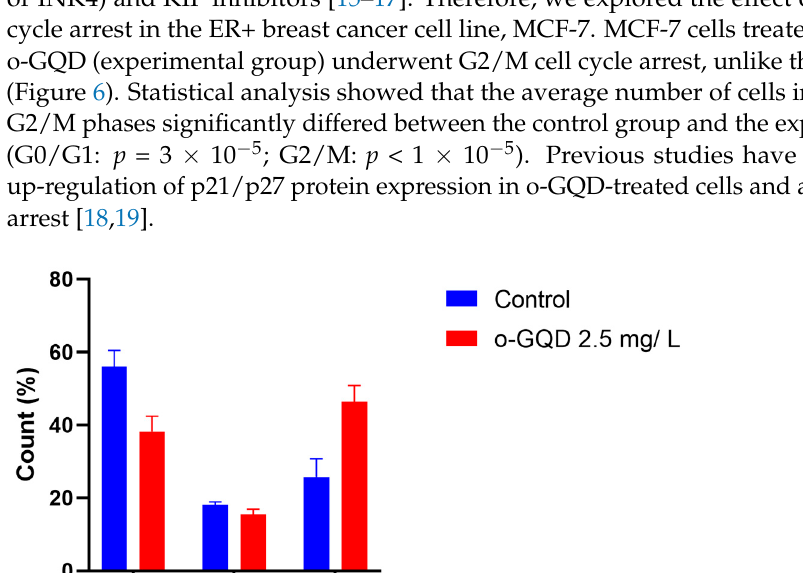
Figure 7. ( a ) Representative Western blot showing the expression of cell cycle-related proteins in MCF-7 cells treated with or without o-GQD for 72, ( b ) and their quantitative evaluation. The data indicate averages from triplicates, and the error bars indicate SD. Significance is determined by us- ing two-way ANOVA statistical analysis. The significant differences are indicated by using *. *: p < 0.05, **: p < 0.01, ***: p < 0.001, ****: p < 0.0001. 3. Discussion Breast cancer, which is heterogeneous on the molecular level, is the most frequent malignancy in women worldwide. The molecular features include the activation of HER2, hormone receptors (ER and PR), and BRCA mutations [20]. Treatment strategies for breast cancer differ depending on the molecular subtype. In-depth research and un- derstanding of the molecular mechanisms of breast cancer and related gene pathways in